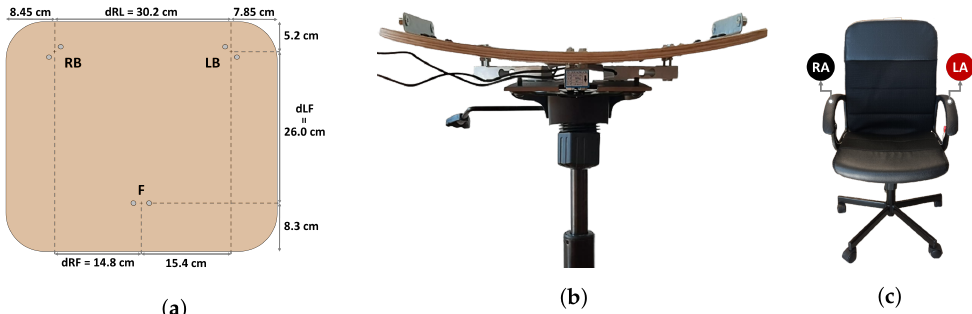
Figure 3. Proposed SPMS and ECG acquisition system: ( a ) diagram of the load cells’ point measure- ments in the chair seat; ( b ) front view of the SPMS; ( c ) position of the ECG electrodes in the chair, right arm (RA) and left arm